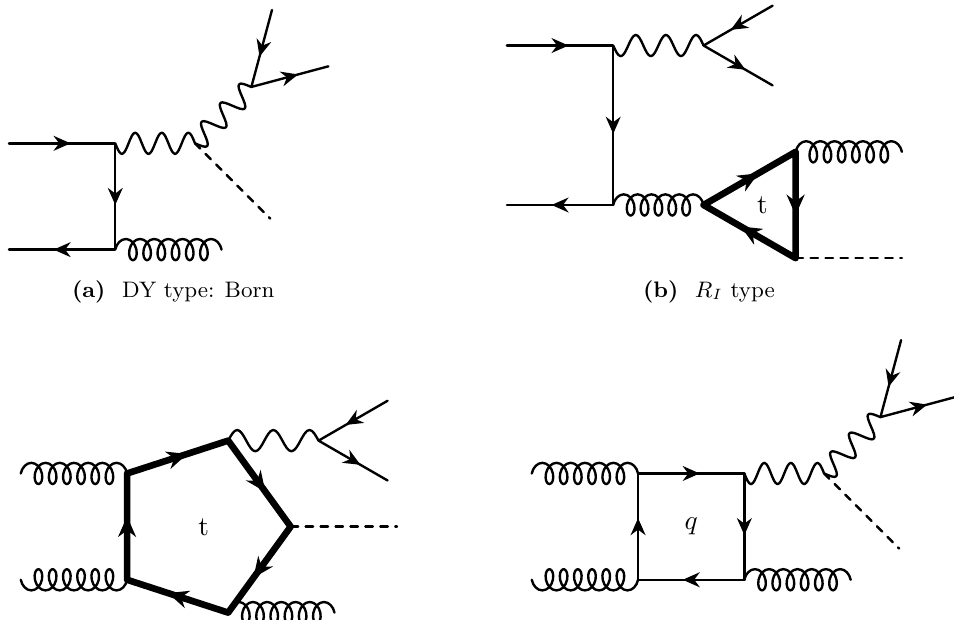
Figure 1. Representative diagrams for the Drell-Yan and heavy-quark loop induced contributions to V H + jet production that enter the cross section at specific order in α s : (a) at order α s for the Drell-Yan process, denoted as DY-type; (b) at order α 2 for the top-loop induced processes, denoted s as R I -type; and (c) at order α 3 for the one-loop gluon-gluon initiated process gg → HZg , denoted s as ggF-type. Details on the individual contributions given in the main